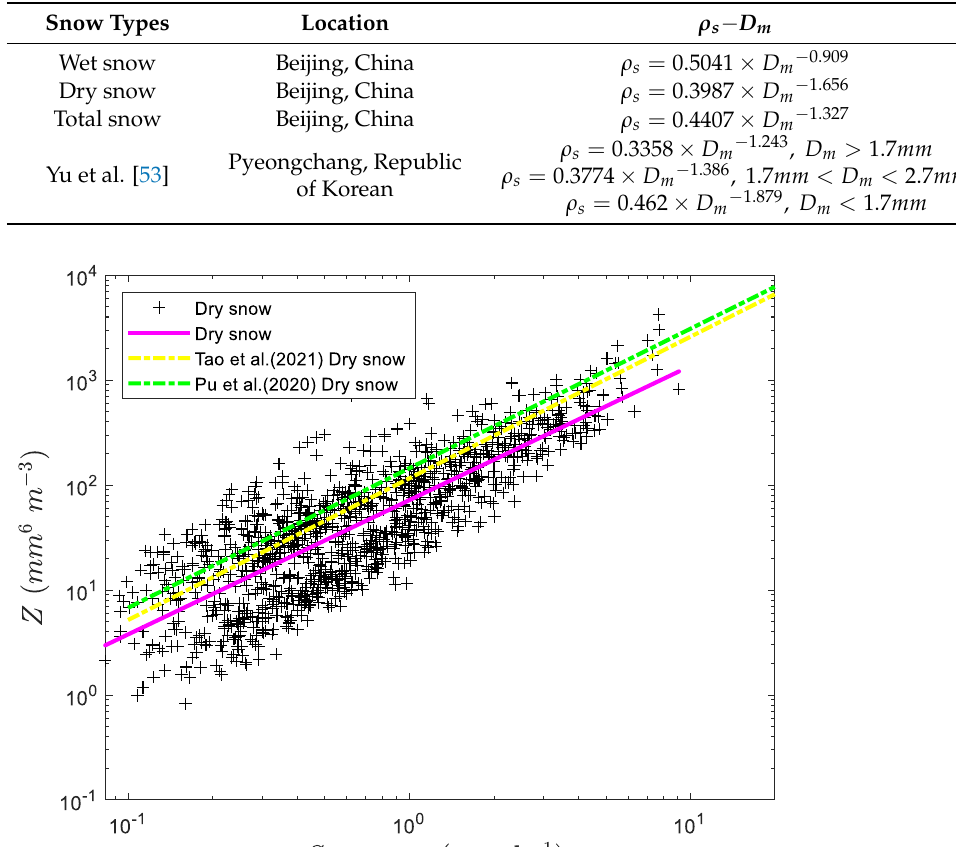
Figure 8. Diameter and density scatterplot of all snowfalls and the ρ s − D m relationship fitting [53]. Table 4. The relationship of ρ s − D m for snow.